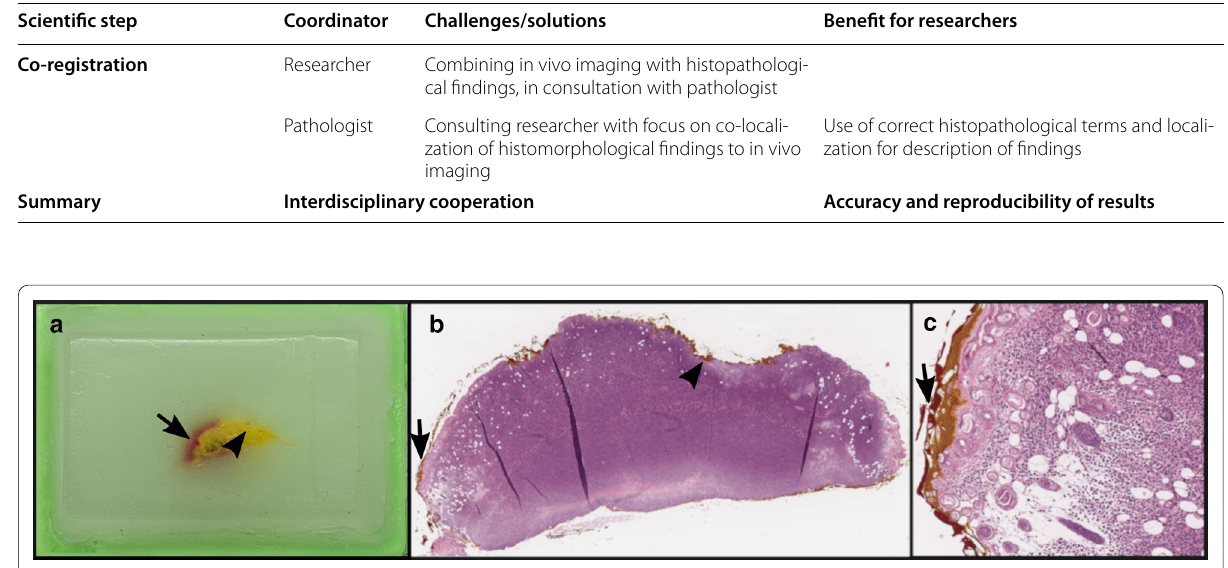
Fig. 2 a two-colored ink marked paraffin-embedded subcutaneous tumor for basic co-localization (arrow: red ink, arrowhead: yellow ink); b H&E stain of a (magnification 2 ); c higher magnification (8 ) of b , two-colored ink marked margin of subcutaneous tumor tissue. Although the yellow × × ink slightly ran into the red ink area, the two colored areas can be well distinguished. Unpublished